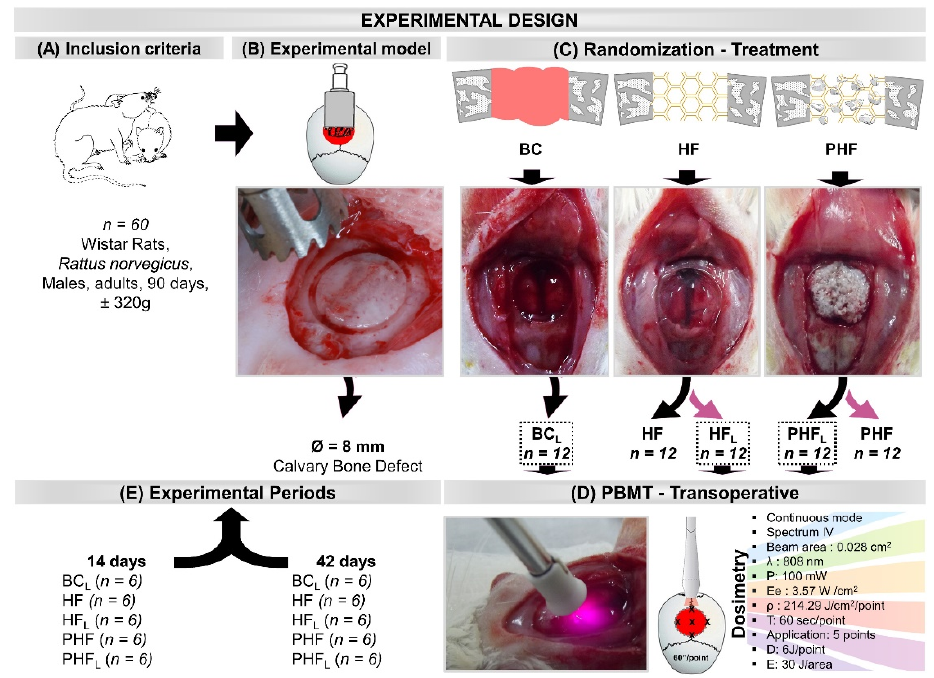
Figure 9. Illustrations and images of the experimental design. ( A ) Inclusion criteria: 60 rats, adults, Rattus norvegicus, Wistar hannover strain, males, age 90 days, body mass of approximately 320 g. ( B ) Experimental model: Bone defect in the center of the parietal bones with the aid of a trephine drill, 8 mm in diameter. ( C ) Randomization ( n = 12/group) and Treatment: BC L —defect filled by blood clot and laser photobiomodulation therapy; HF—defect filled by heterologous fibrin biopolymer; HF L —defect filled by heterologous fibrin biopolymer and photobiomodulation; PHF—defect